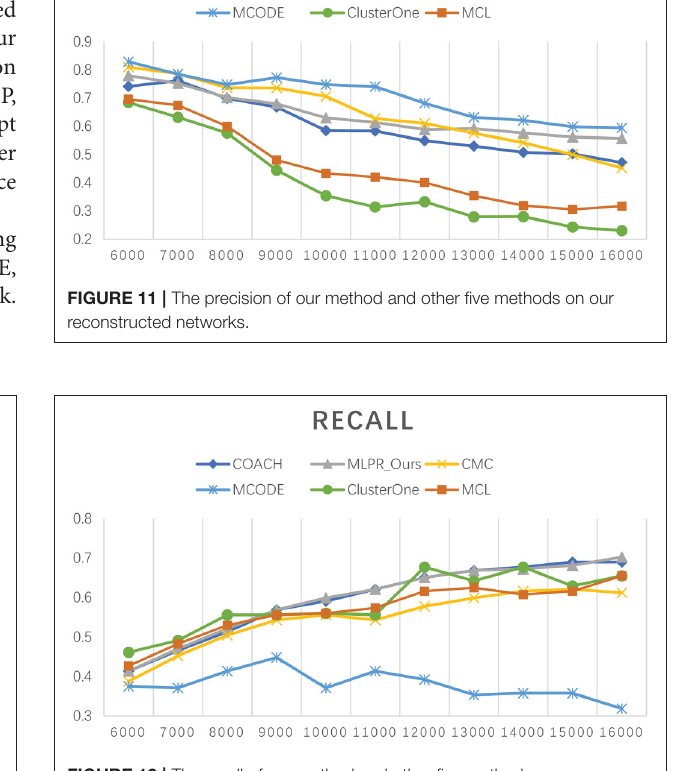
FIGURE 9 | The performances comparison between our method and other five methods on Collins dataset.